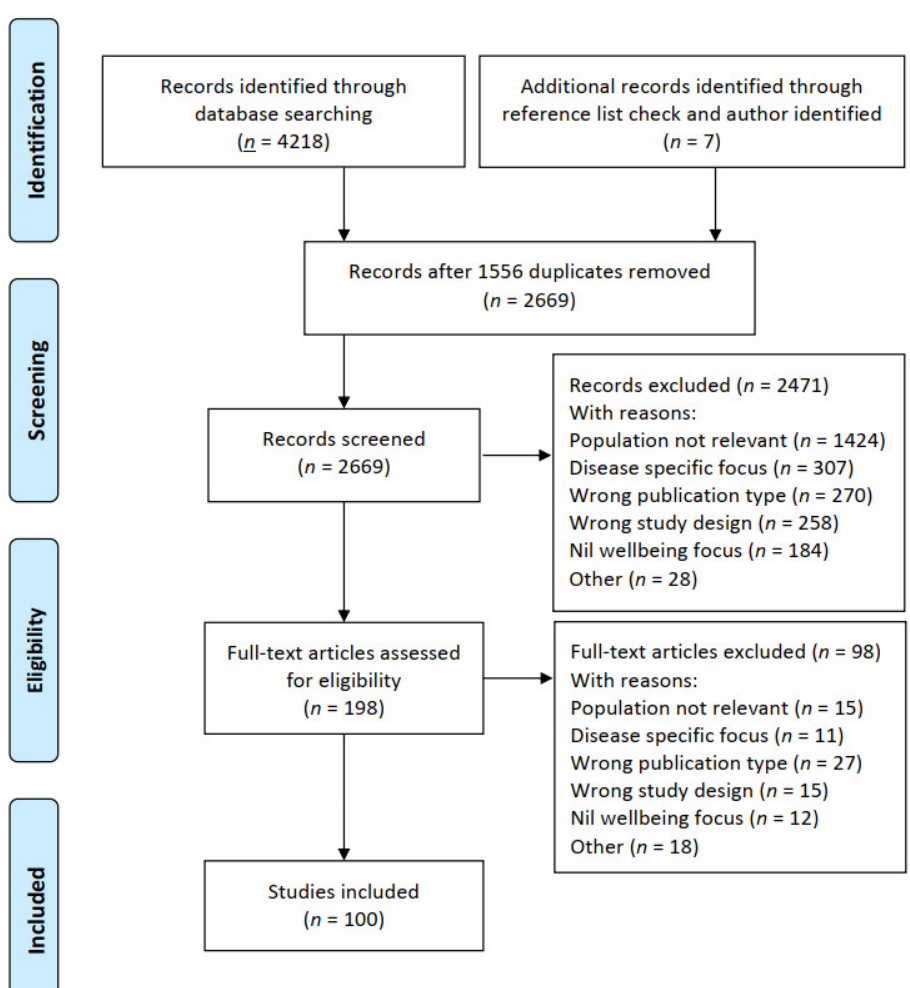
Figure 1. PRISMA schema.